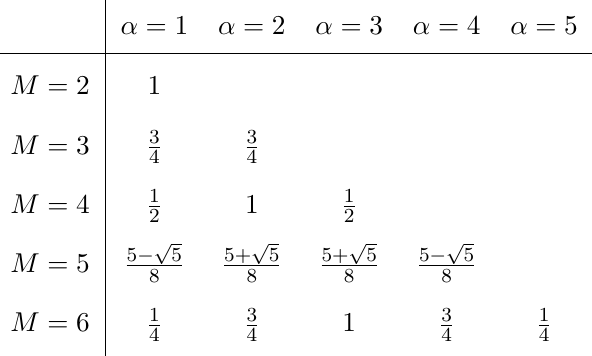
(cid:1) = sin 2 (cid:0) πα α M